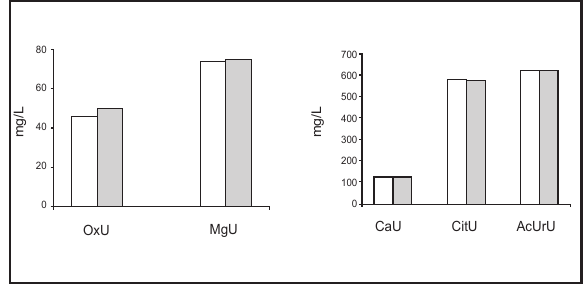
Figura 2 – Parâmetros urinários em amostras isoladas de urina com adição prévia (barras brancas) ou 24 horas após a coleta (barras pontilhadas) de conservante ácido